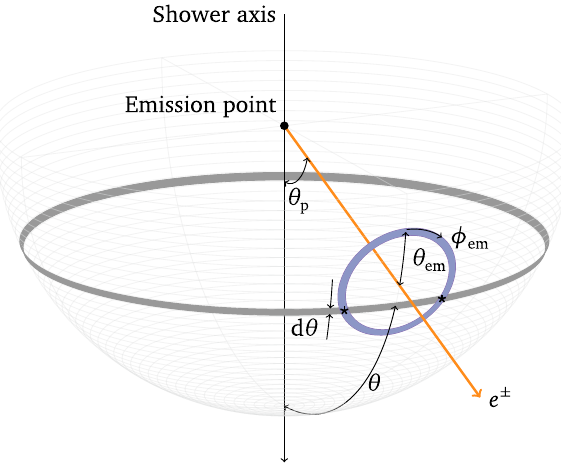
Fig. 2 Depiction of the intersecting region between the Cherenkov cone (blue ring) and the ring of width d θ around the angle θ (grey ring) in the unit sphere. There are two intersection points whenever | θ − θ | < θ p em and none